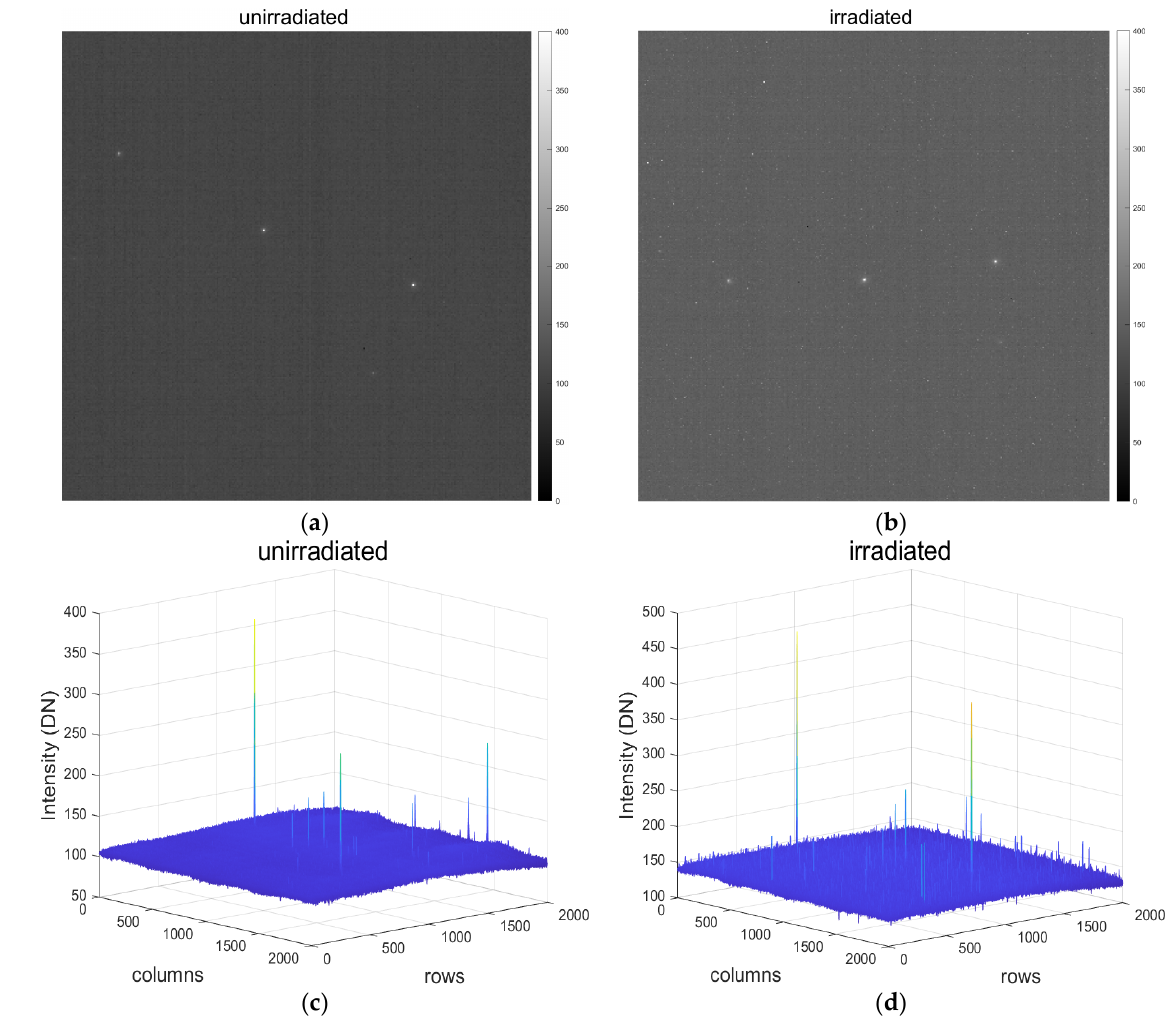
Figure 3. Star maps containing Orion’s Belt and 3D point maps. ( a ) Star map captured with unirradiated CMOS image sensor; ( b ) star map captured with CMOS image sensor irradiated with a fluence of 1.47 × 10 10 p/cm 2 . ( c ) 3D point map constructed from low-pass filtered unirradiated image; ( d ) 3D point map constructed from low-pass filtered irradiated image.